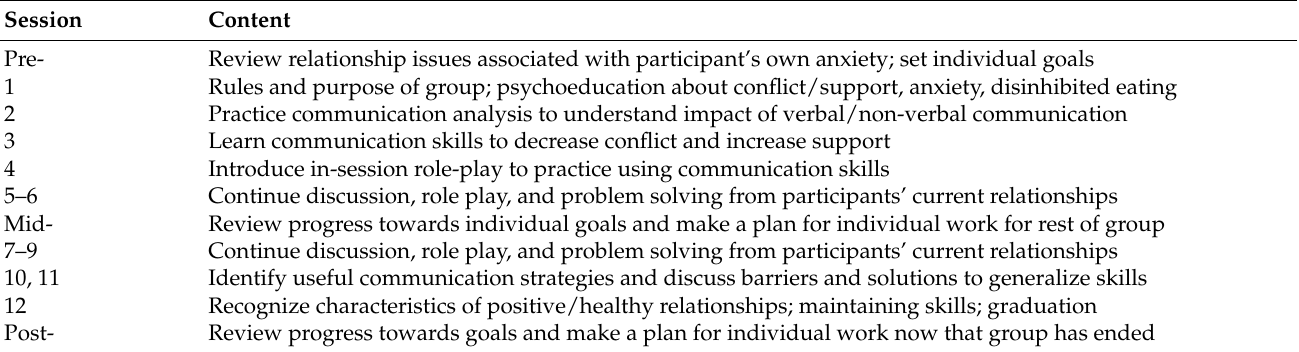
Table 3. Summary of IPT session